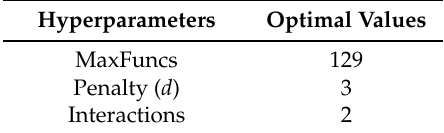
Table 5. Optimal hyperparameters of the best fitted MARS model found with the ABC technique.